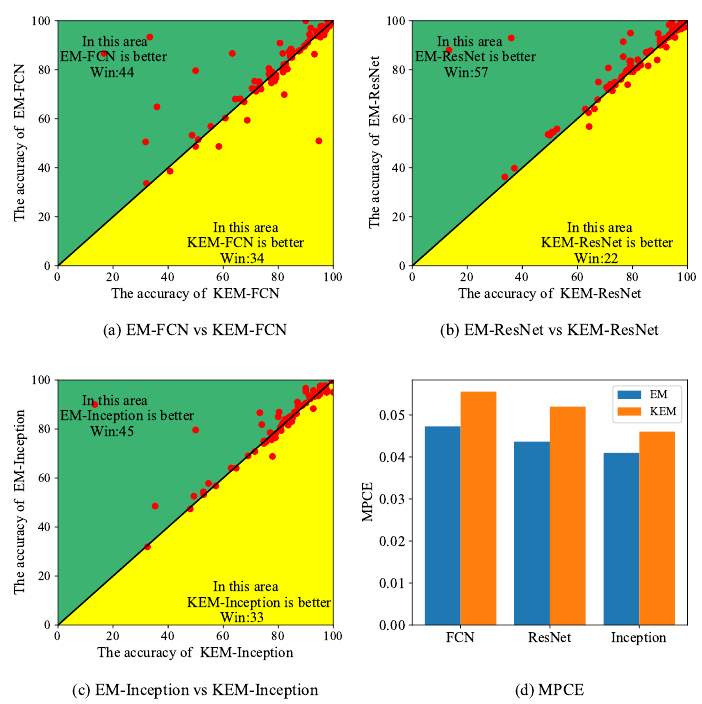
Figure 11. Comparison between the EM-CNN and KEM-CNN. ( a ) shows the comparison between EM-FCN and KEM-FCN, ( b ) shows the comparison between the EM-ResNet and KEM-ResNet, ( c ) shows the comparison between the EM-Inception and KEM-Inception, ( d ) shows the MPCE based on different